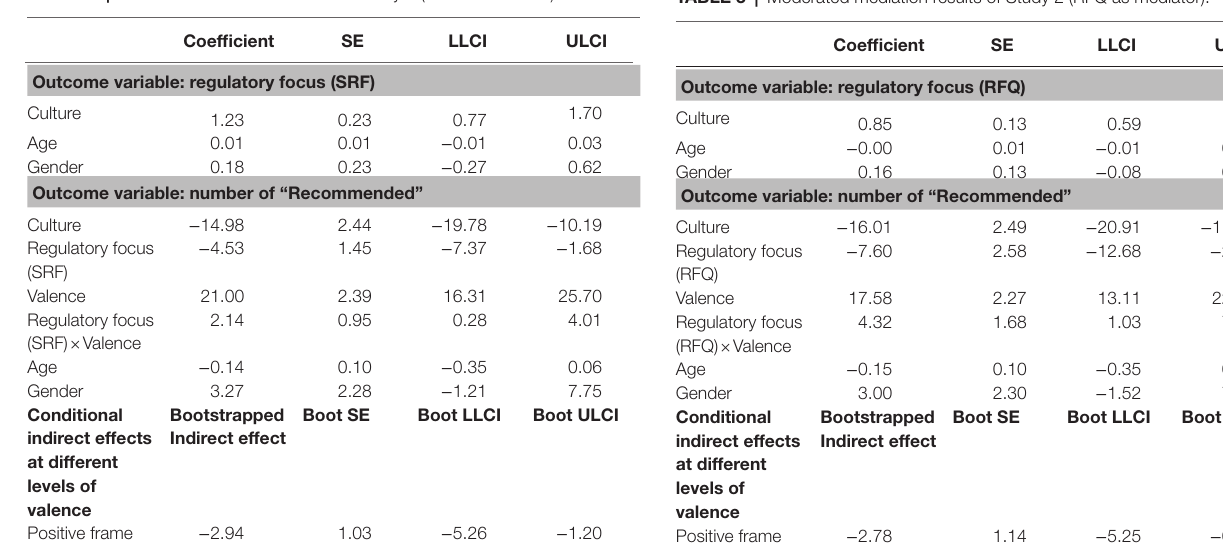
TABLE 2 | Moderated mediation results of Study 2 (SRF as mediator). TABLE 3 | Moderated mediation results of Study 2 (RFQ as